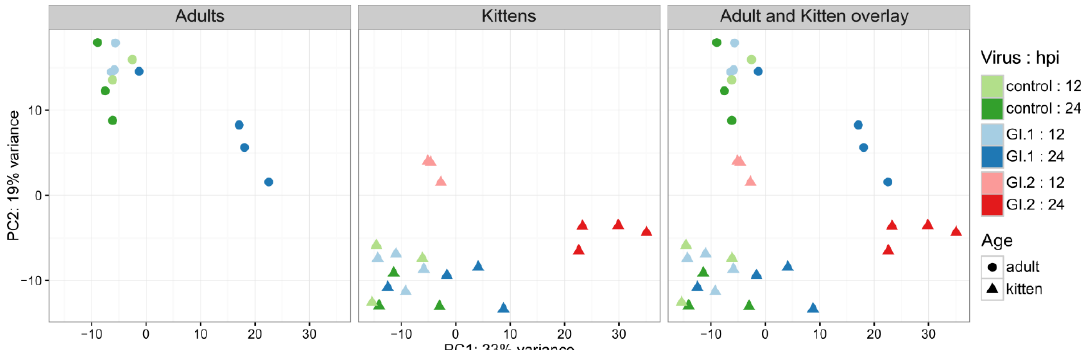
Figure 1. Similarity of gene expression profiles across rabbit age cohorts during infection with different GI viruses. GI.1-infected kittens had the smallest transcriptomic response after infection, while large changes were observed from 12 hpi in GI.2-infected kittens, and in GI.1-infected adults at 24 hpi. Notably, expression profiles varied considerably between adult and kitten control rabbits. Expression values from the top 500 most variable genes across the samples were normalized using regularized log transformation and plotted using principal component analysis.